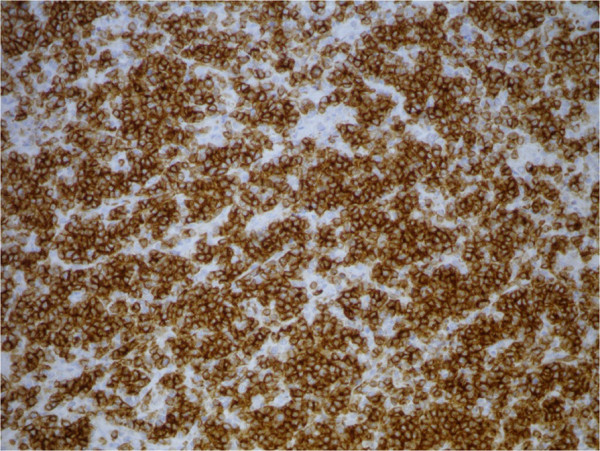
Spleen: CD56 IHC, 20×.